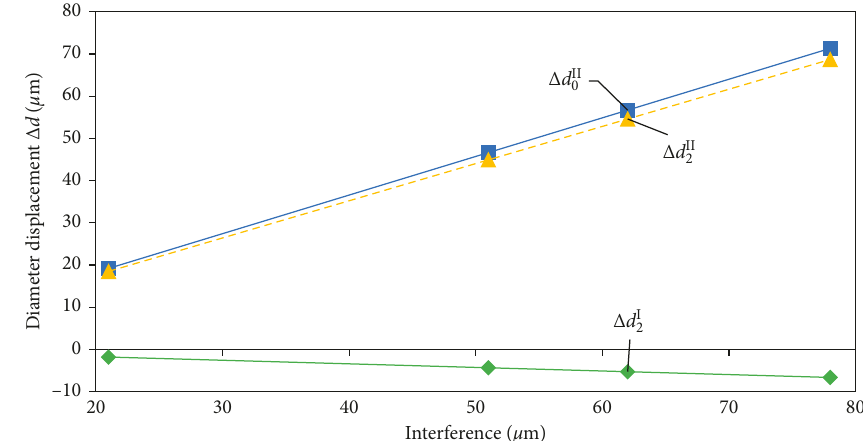
Figure 12: Inner bearing rolling race diameter displacement